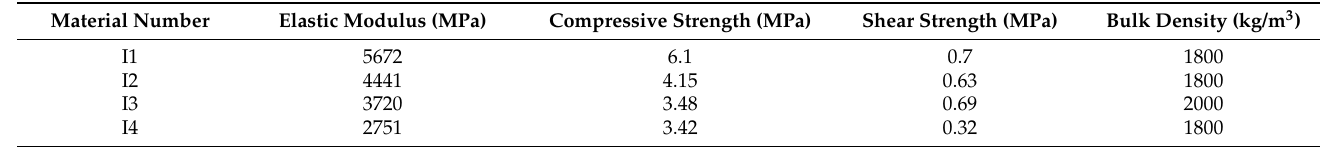
Table 4. The mechanical property parameters of masonry material.